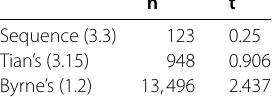
Table 4 (cid:2) = 10 –10 , P = 10, M = 10, N =